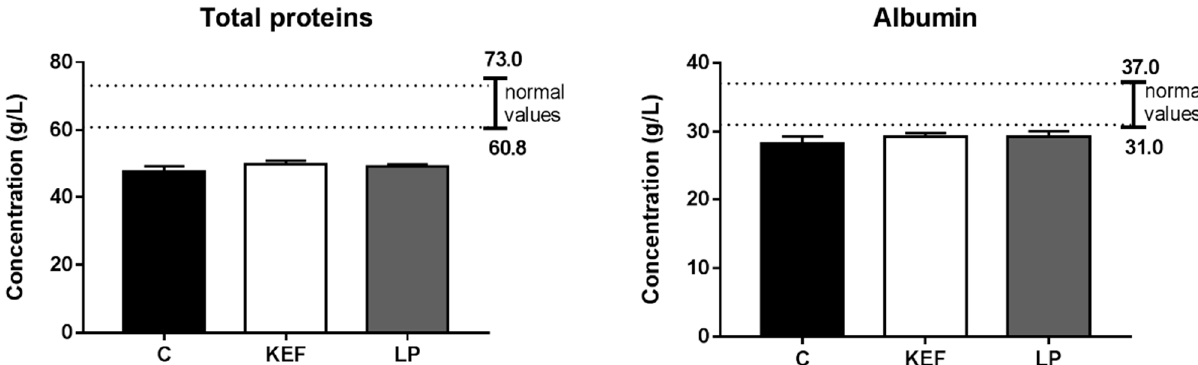
Figure 6. Effect of application of L. paracasei Ž2 and kefir on the concentration of total proteins and albumin in the serum of mice following treatment. The ranges of recommended normal values are indicated by lines. No significant differences were detected among individual groups.